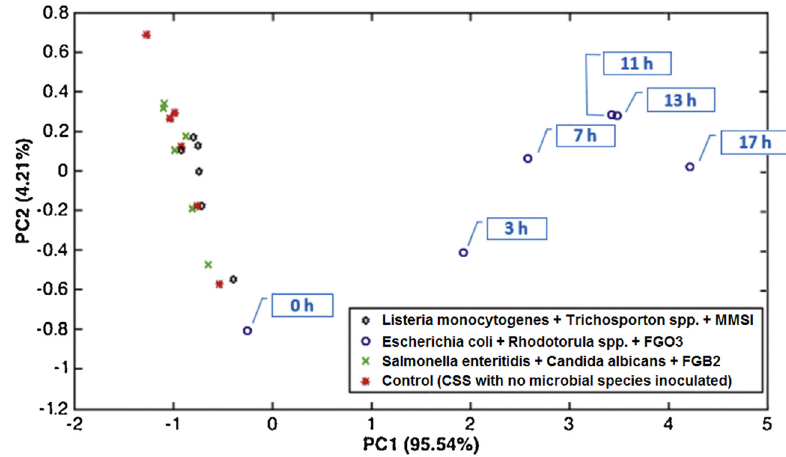
Figure 14: A PCA plot of di ff erent microbial blends along the 20 h analysis. Modi fi ed with permission from ref. [ 84 ]